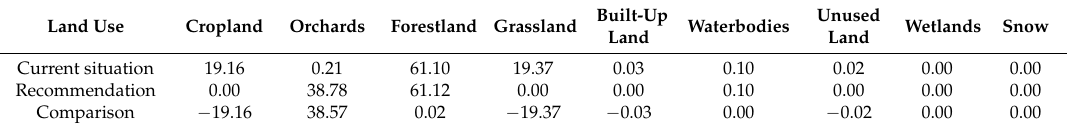
Built-Up Unused Waterbodies Wetlands Snow Land Land